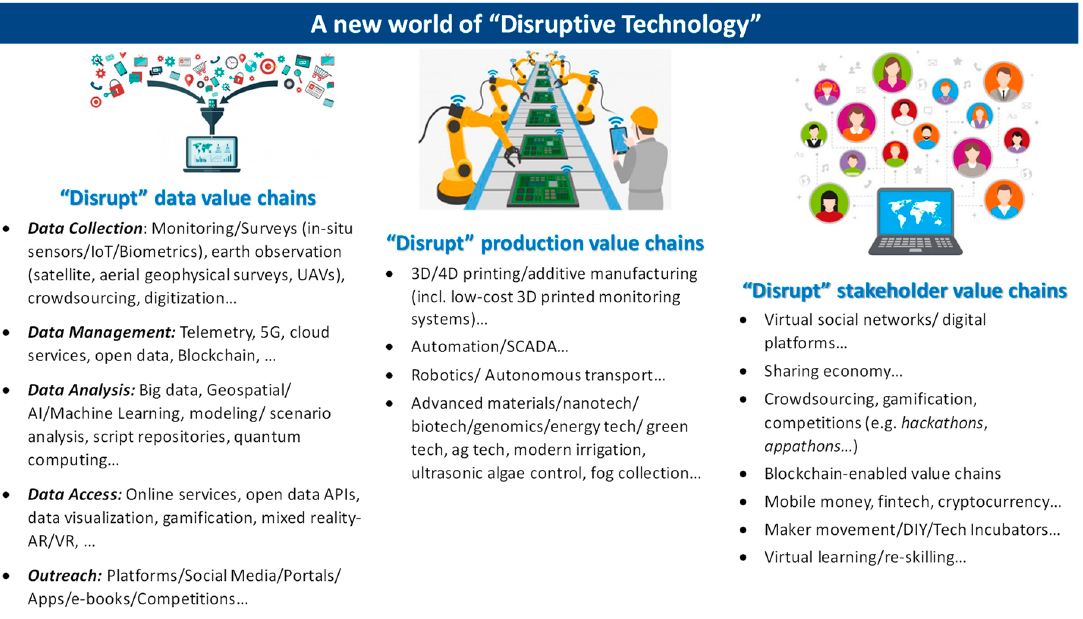
Figure 3. Typology of ‘disruptive’ technologies.